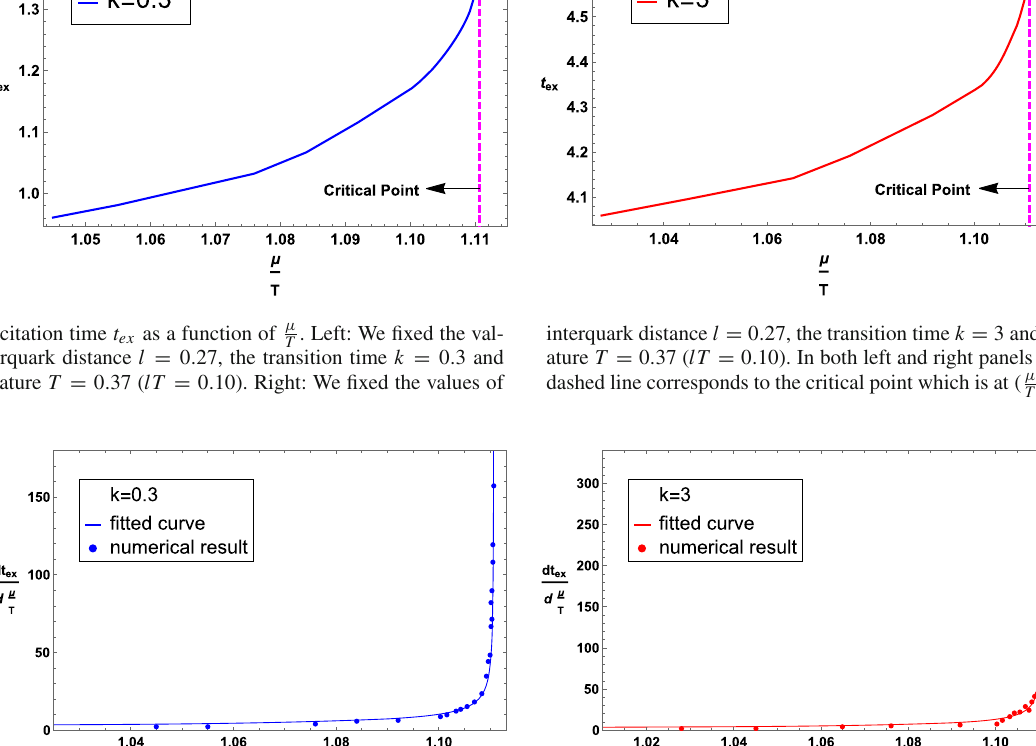
. Left: We fixed the val- interquark distance l = 0 . 27, the transition time k = 3 and the temper- T ature T = 0 . 37 ( lT = 0 . 10). In both left and right panels the magenta dashed line corresponds to the critical point which is at ( μ